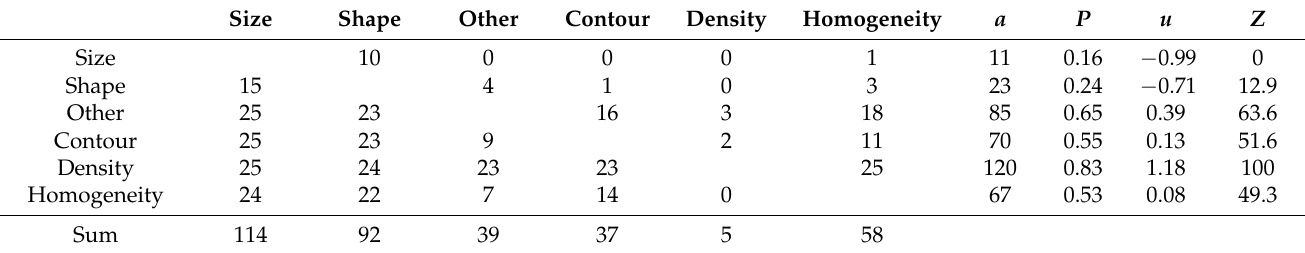
Table 3. Aggregated preference table. The number of attributes is n = 6, the number of consistent experts is m = 25. The layout is similar to Table 1. Column a is the total number of cases when the given attribute is preferred (this is shown in the later figures). Value P is the aggregated preference rate (7), u is the corresponding standard normal distribution value, and Z is the weight in %, according to